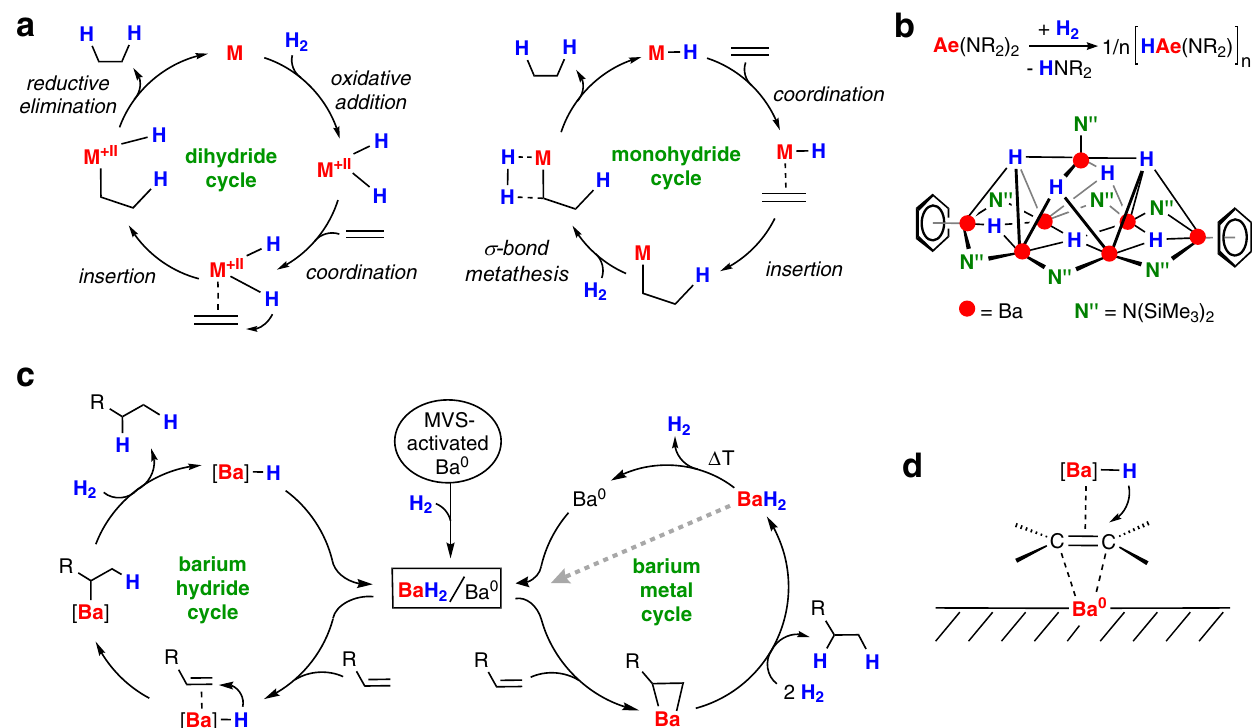
Fig. 2 General mechanisms for alkene hydrogenation. a The two fundamental cycles in transition metal-catalyzed alkene hydrogenation. b Formation of [Ae(H)NR 2 ] n aggregates (Ae = Ca, Sr, Ba) for catalytic alkene hydrogenation and an example of a structurally characterized [Ba(H)N ” (C 6 H 6 ) 2 ] 7 aggregate. c The two possible catalytic cycles for alkene hydrogenation with activated barium metal. d Proposed dual-site mechanism for Ba 0 promoted alkene